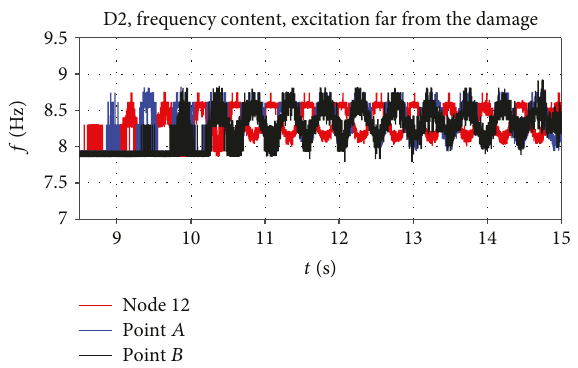
Figure 59: D2, maximum frequency, excitation far from the damage.